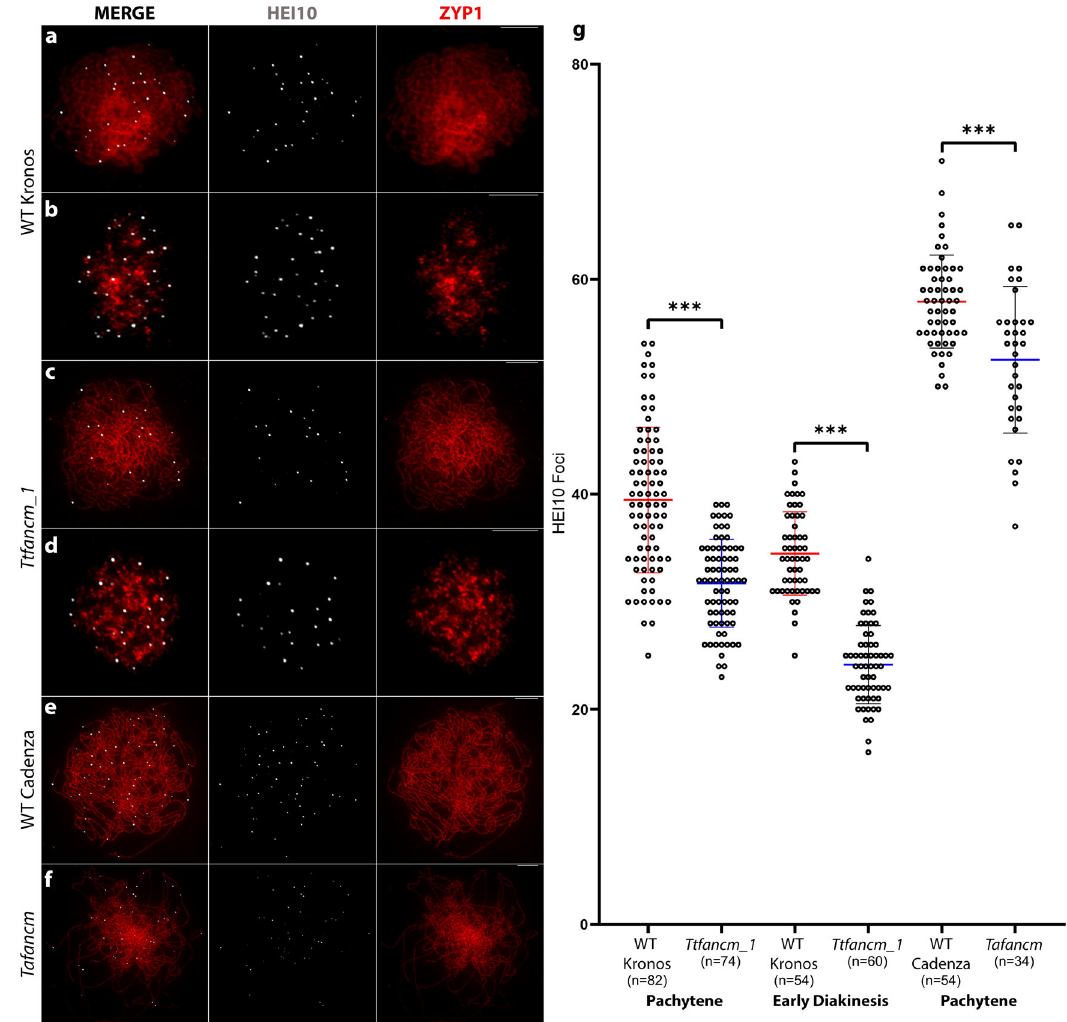
Fig. 2 Class I crossover recombination protein HEI10 is reduced in fancm null mutants at late prophase I. a – f Co-immuno fl uorescence of HEI10 (white) and ZYP1 (red) on meiotic prophase I chromosome spreads. Representative micrographs are shown from replicates, ( a ) ( n = 82), ( b ) ( n = 74), ( c ) ( n = 54), ( d ) ( n = 60), ( e ) ( n = 54), and ( f ) ( n = 34). Pachytene ( a , c , e and f ) and early diakinesis ( b and d ). Scale bars = 10 µ m. g Counts of HEI10 foci per cell with mean values ± SD. The number of meiocytes sampled for each line is shown in brackets. *** = p < 0.001 (Mann – Whitney U Test). Source data are provided as a Source Data fi le.